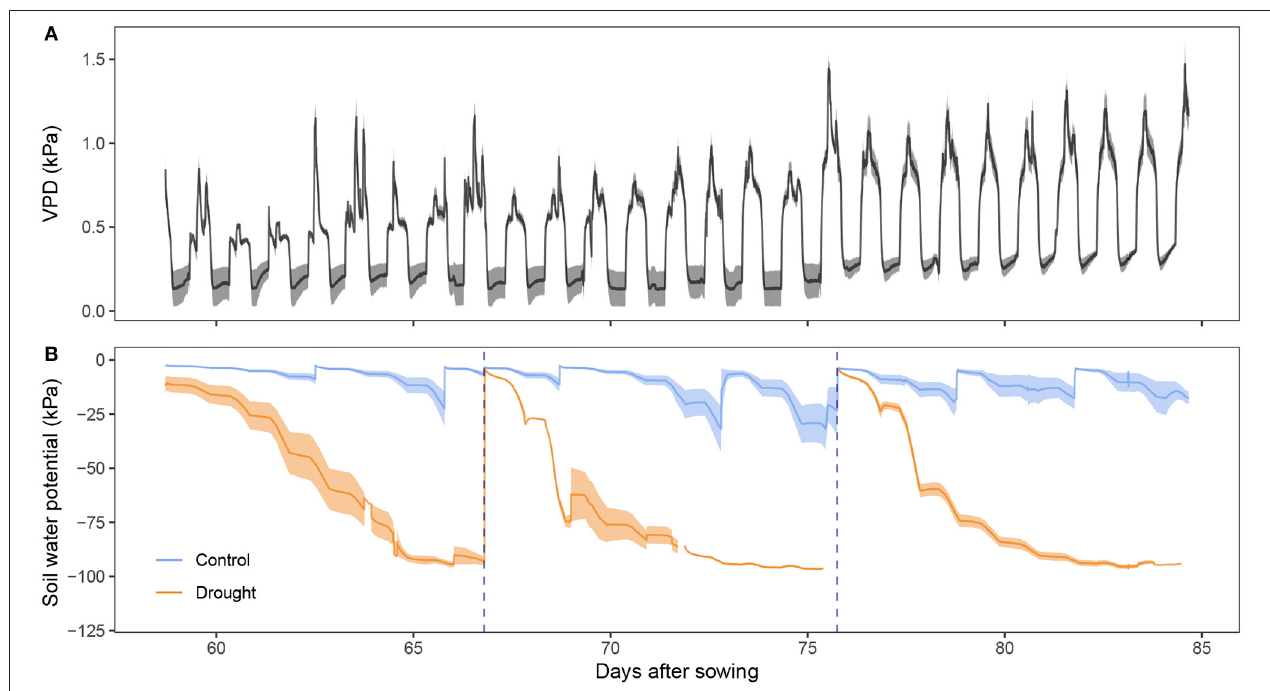
FIGURE 1 | Growing environment of the wheat plants. (A) Vapor pressure deficit (VPD, kPa, n = 2) present in the growth chamber. (B) Soil water potential (kPa, n = 4) measured with tensiometers. Darker lines represent the mean while the lighter band the standard error. Rewatering events are marked with a blue dotted line.